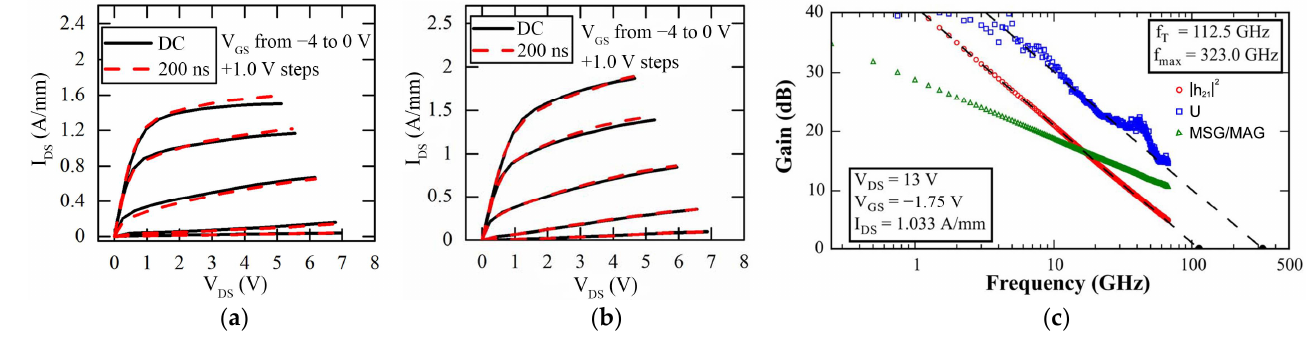
Figure 10. ( a ) DC and pulsed I DS –V DS measurements of the NPDR MIS-HEMT, fabricated by Wienecke et al. in 2016. Adapted with permission from Ref. [55]. Copyright 2016 by IEEE. ( b ) DC and pulsed I DS –V DS measurements and ( c ) small-signal RF performance of the NPDR MIS-HEMT with gate-sidewall overlapping, fabricated by Steven et al. in 2017. Adapted with permission from Ref. [49]. Copyright 2017 by